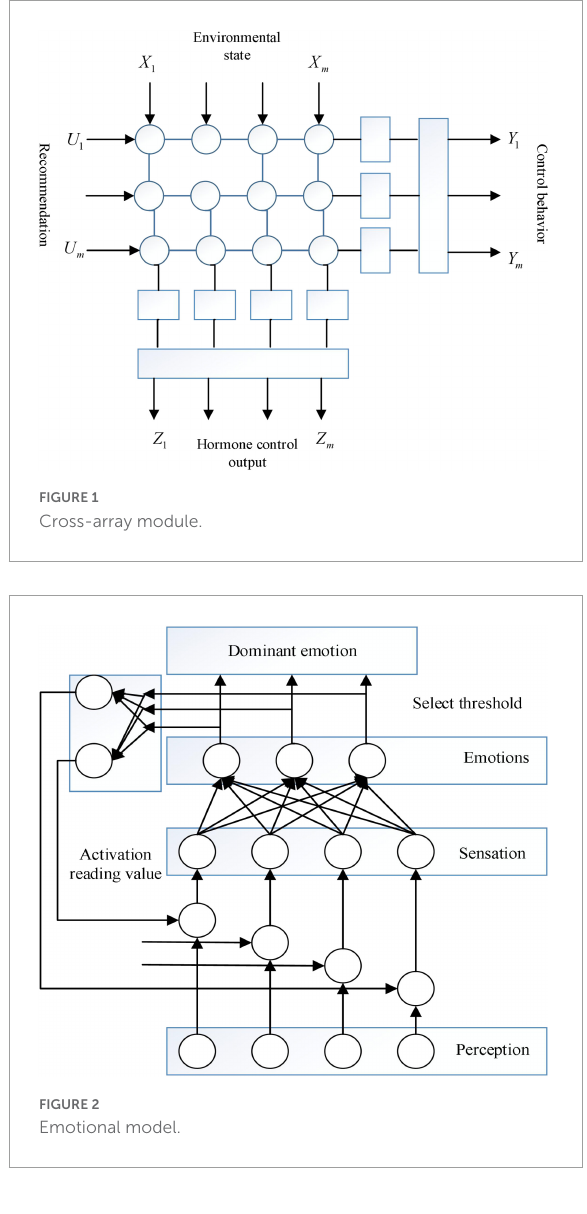
FIGURE2 Emotional